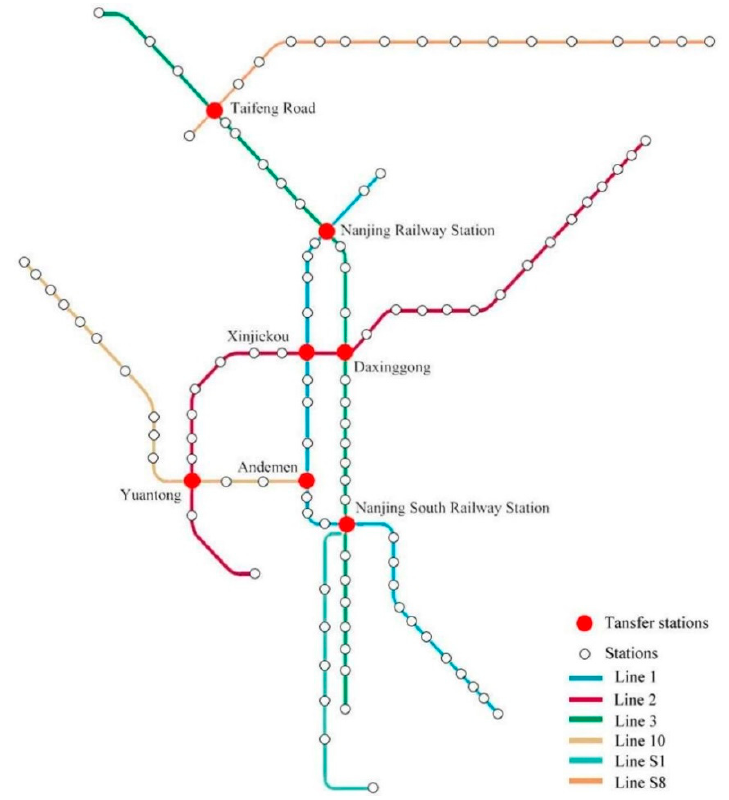
Figure 1. Nanjing rail transit network (2016). The figure displays the network topology and transfer relationships between different rail transit lines (based on the Nanjing subway rail route map).